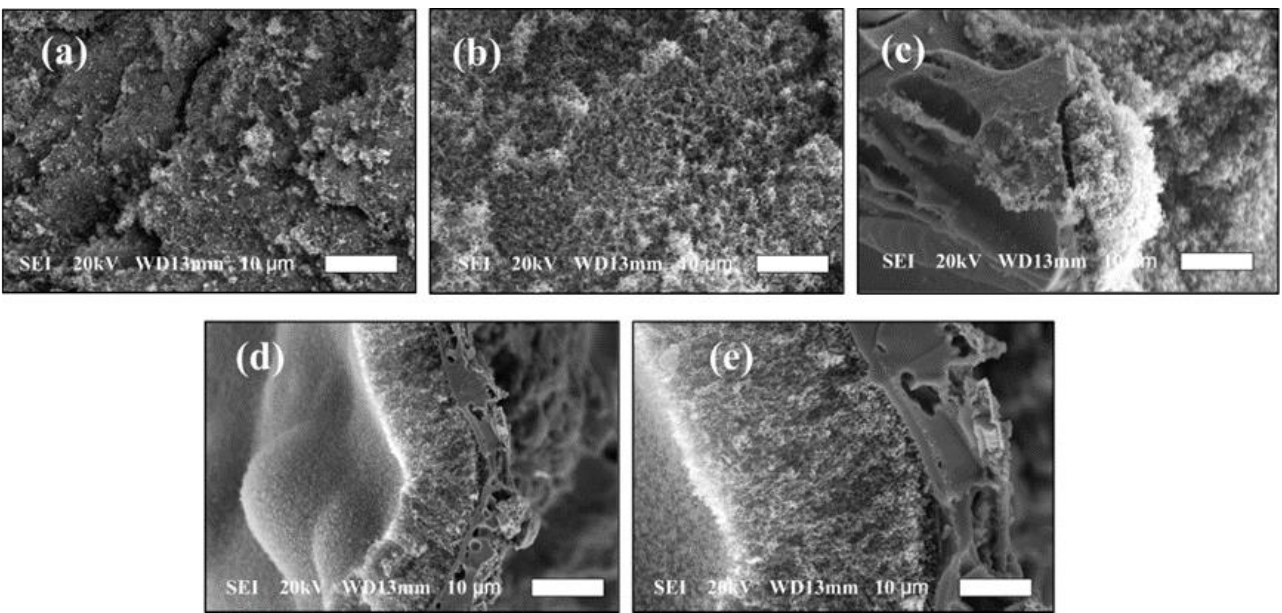
Figure 5. SEM of char residues of: ( a ) EP, ( b ) E-HS-5, ( c ) E-HS-10, ( d ) E-HS-15 and ( e ) E-HS-20.